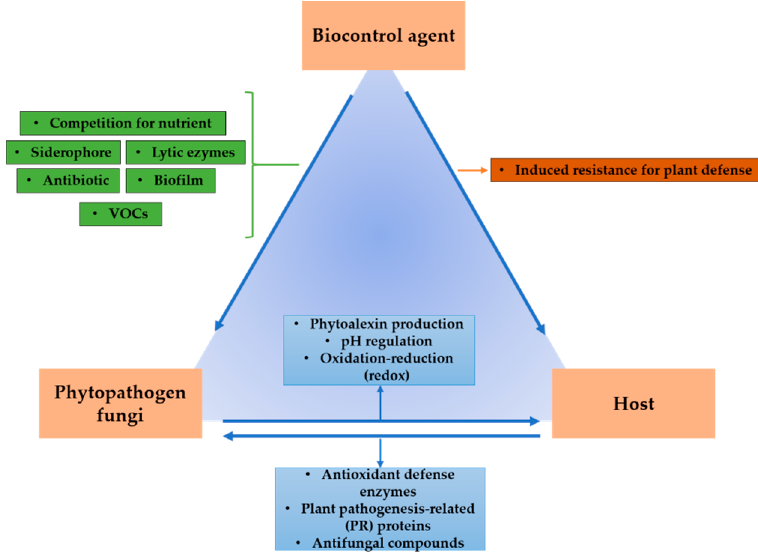
Figure 1. Mechanisms of action of biocontrol agents.